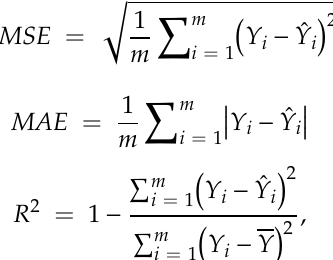
. Figure 1 . Schematic